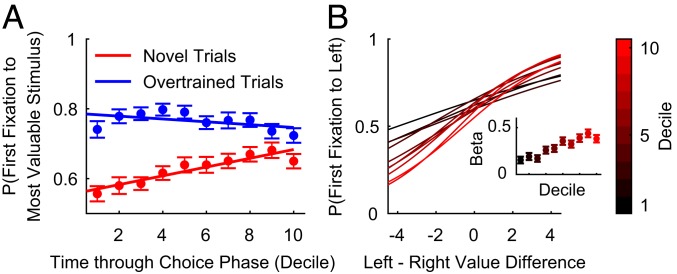
Subjects learn to direct their first fixation toward more valuable novel stimuli during a session. (A) The mean (±SEM) proportion of trials where the subjects’ first fixation was toward the more valuable stimulus, as a function of session decile. On the earliest novel trials, subjects’ first fixation direction is not influenced by value. However, as the stimulus values are learned, subjects develop a preference to fixate the more valuable stimulus first. On overtrained trials, subjects consistently fixate the more valuable stimulus first. (B) Logistic fit of the probability of fixating the left stimulus first as a function of left–right stimulus value difference for novel trials. The data are split by session decile. (B, Inset) The regression coefficient (±SE) quantifying the effect of value on fixation direction in each trial decile. On novel trials, first fixation direction is increasingly influenced by stimulus values as the session progresses.